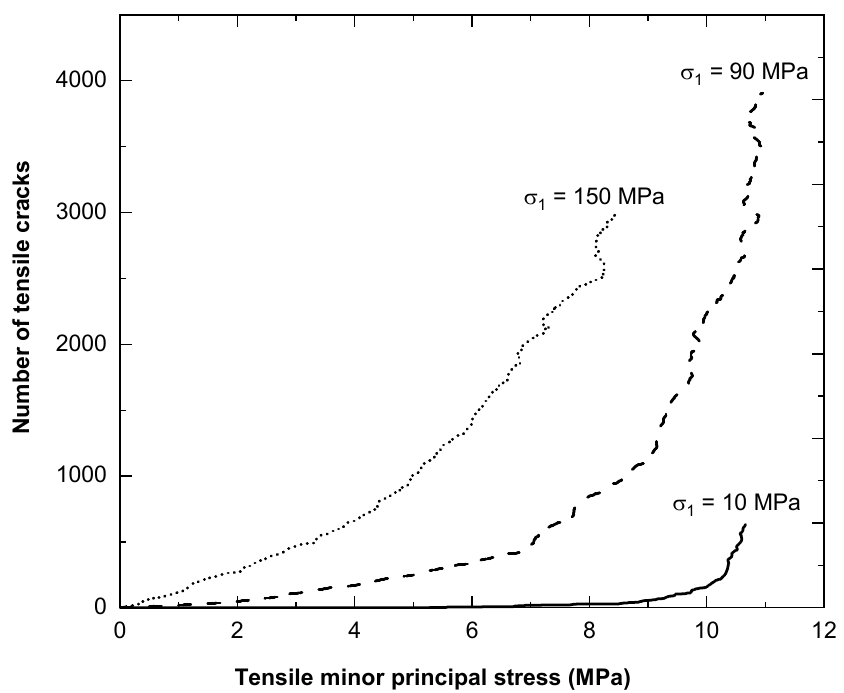
Figure 13. Number of tensile cracks formed with an increase in σ 3 for numerical confined extension tests at low (10 MPa), medium (90 MPa), and high (150 MPa) confinements (from point E to point C; Figure 8).